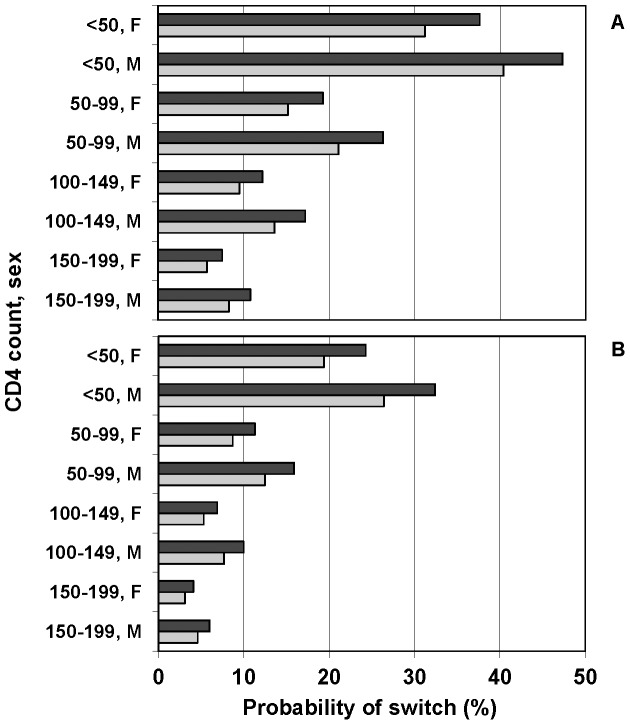
Estimated probability of switching to second-line ART by baseline CD4 count and sex.Legend: Probability of switching by 5 years. A) triple NRTI regimens (B) ZDV/3TC/NVP. Black bars denote LCM group; grey bars denote CDM group.